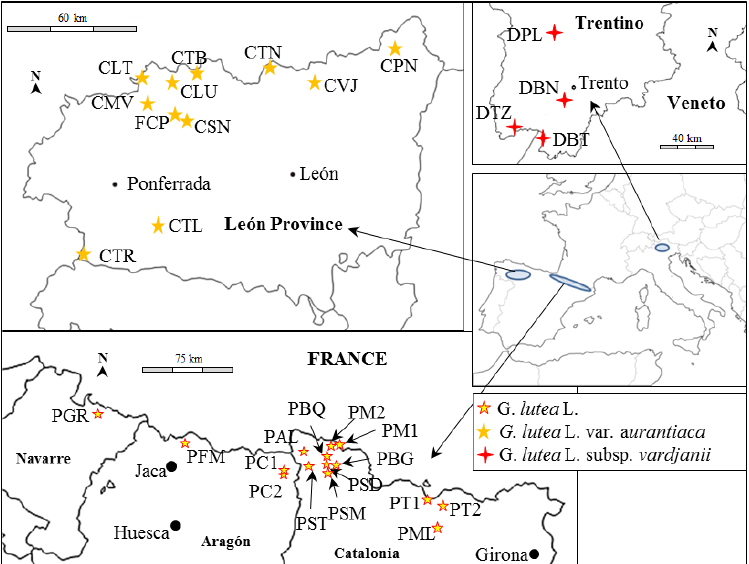
Figure 4. Maps showing the location of sampled populations of Gentiana lutea L., G. lutea subsp. vardjanii and G. lutea var. aurantiaca. Population names correspond to those given in Table